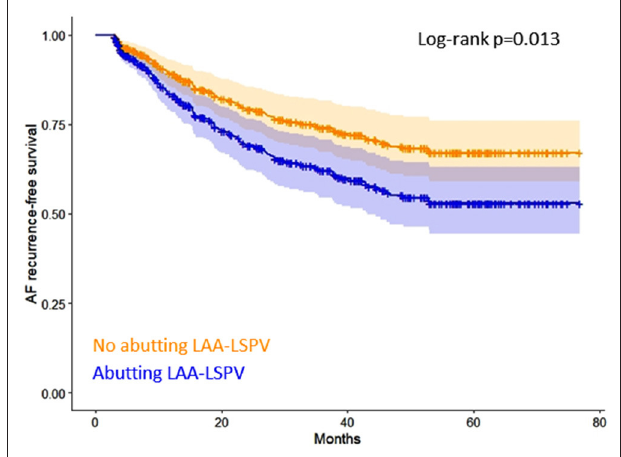
FIGURE 2 | Kaplan-Meier curves of AF recurrence-free survival based on the presence or absence of abutting LAA-LSPV. AF, atrial fibrillation, LAA, left atrial appendage, LSPV, left superior pulmonary vein.